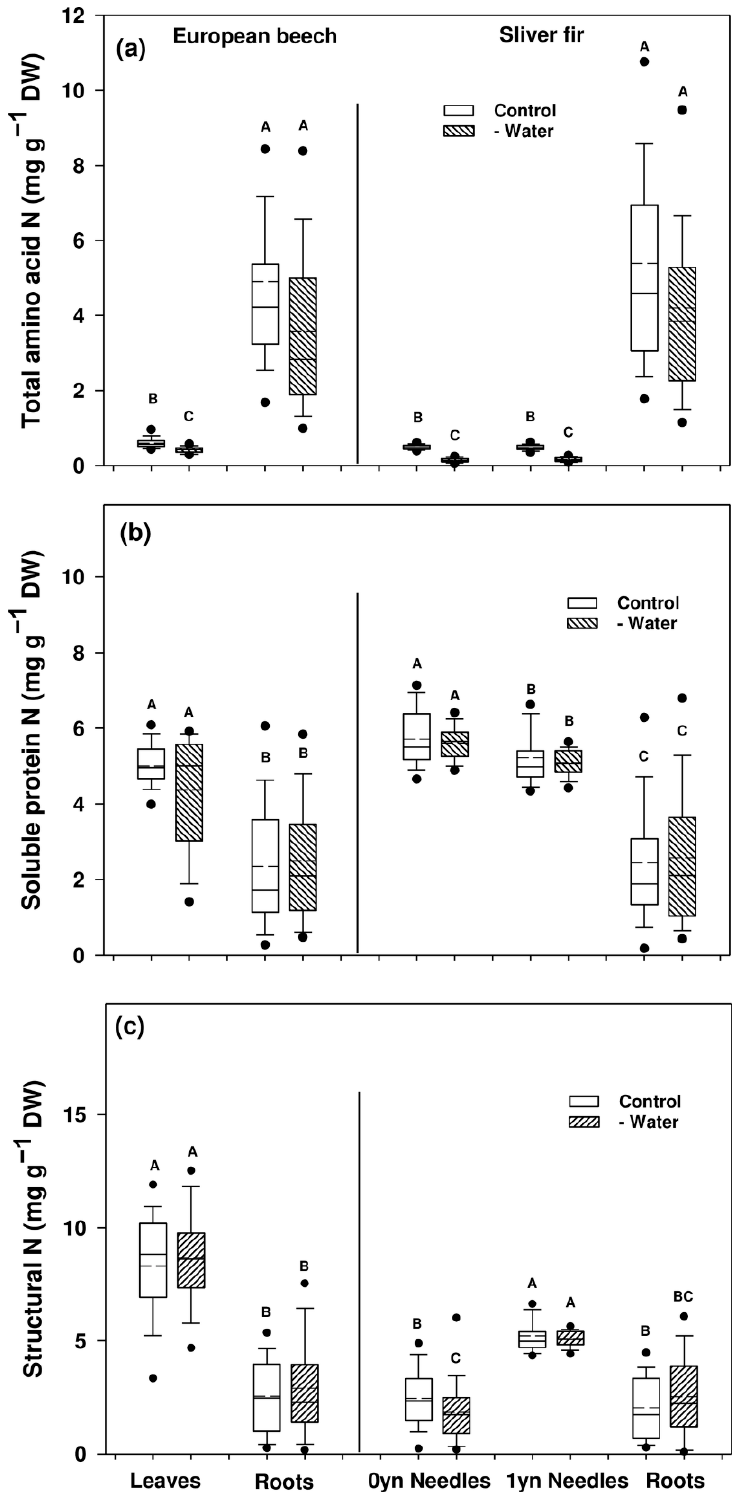
Figure 5. Total amino acid N ( a ), protein N ( b ), and structural N ( c ) of European beech and silver fir seedling after two years of growth in mixed cultivation regardless of the number of inter-species neighbors. -Water: Beech/fir mixtures exposed water deprivation and rewatering during the first year of growth. Data shown are means ± SD (beech: n = 70–77; fir n = 67–77). Significant differences ( p < 0.05) are indicated by different capital letters.